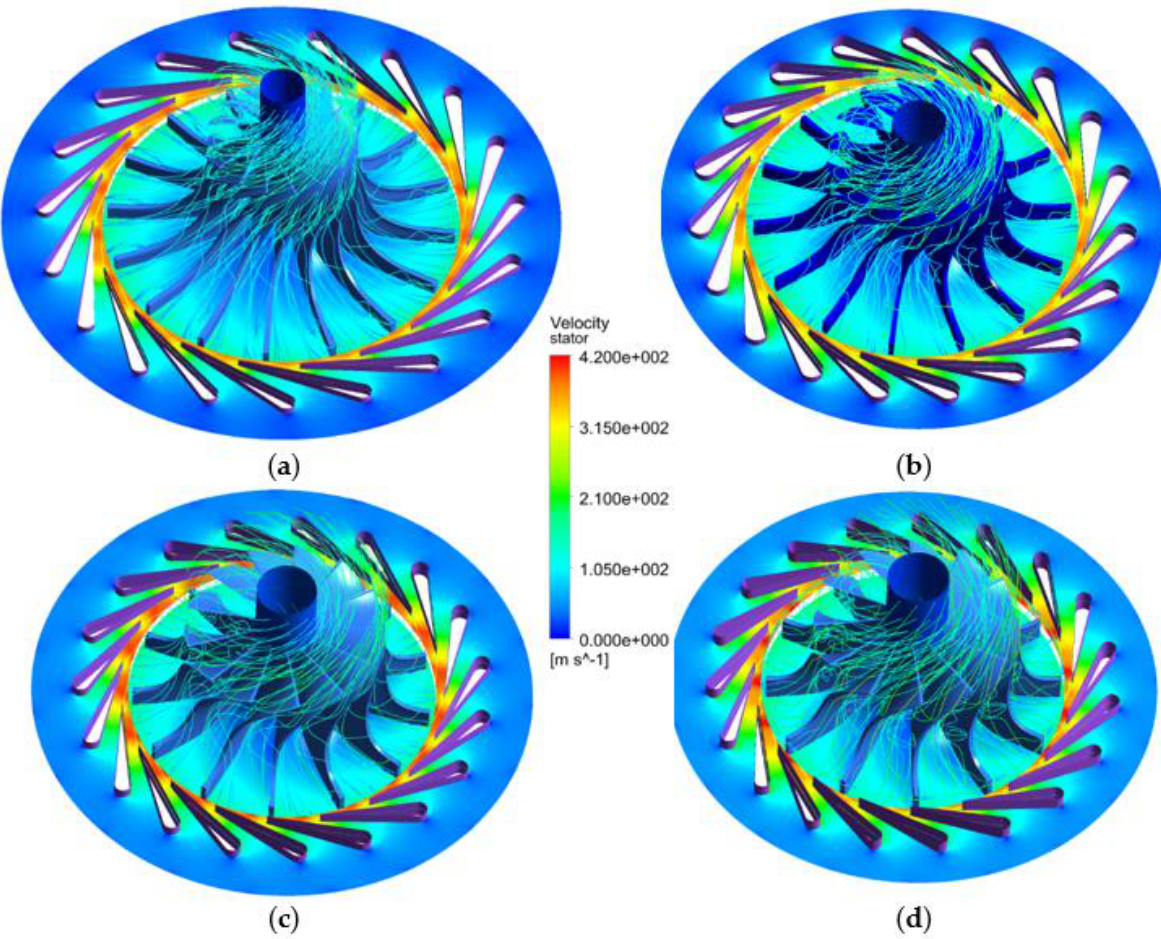
Figure 9. Effect of turbine design specific speed on turbine flow field, ( a ) Ns = 0.35, ( b ) Ns = 0.45, ( c ) Ns = 0.55 and ( d ) Ns = 0.65. In the stator the velocity magnitude is presented and the velocity scale in m/s is also given. In the rotor flow streamlines are shown in a rotating frame.